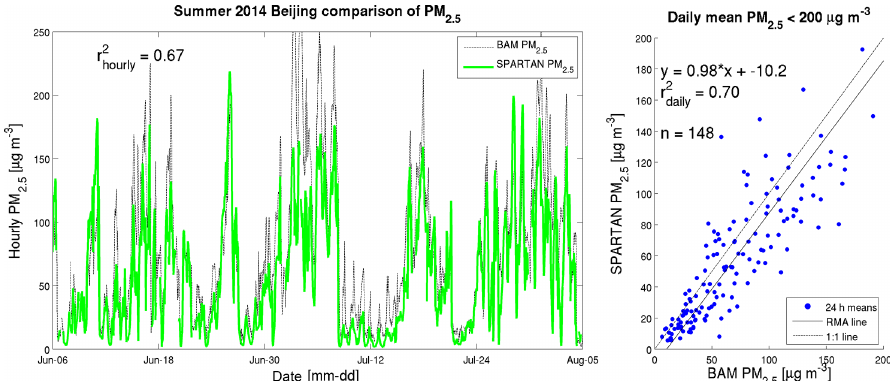
Figure 4. Left: hourly PM 2 . 5 estimated from SPARTAN overlaid with a MetOne BAM-1020 (June–August 2014) at the Beijing US em- bassy (15km away). Right: 24h SPARTAN PM 2 . 5 compared with BAM for the year 2014. Reduced major axis (RMA) slope and Pearson correlations for PM 2 . 5 are given in